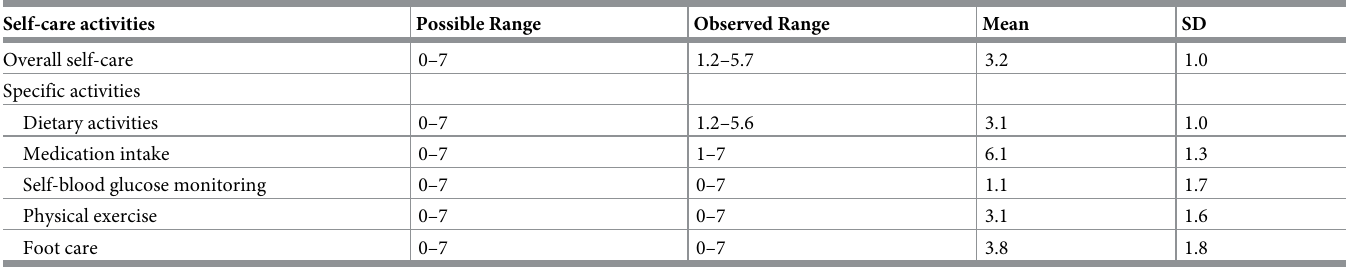
Table 4. General and domain diabetic self-care practice of diabetic patients in JUMC, 2020. Self-care